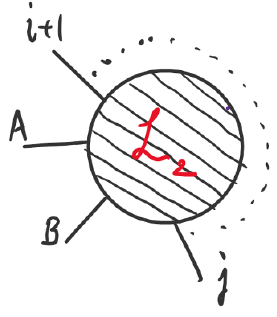
Figure 5 . The right